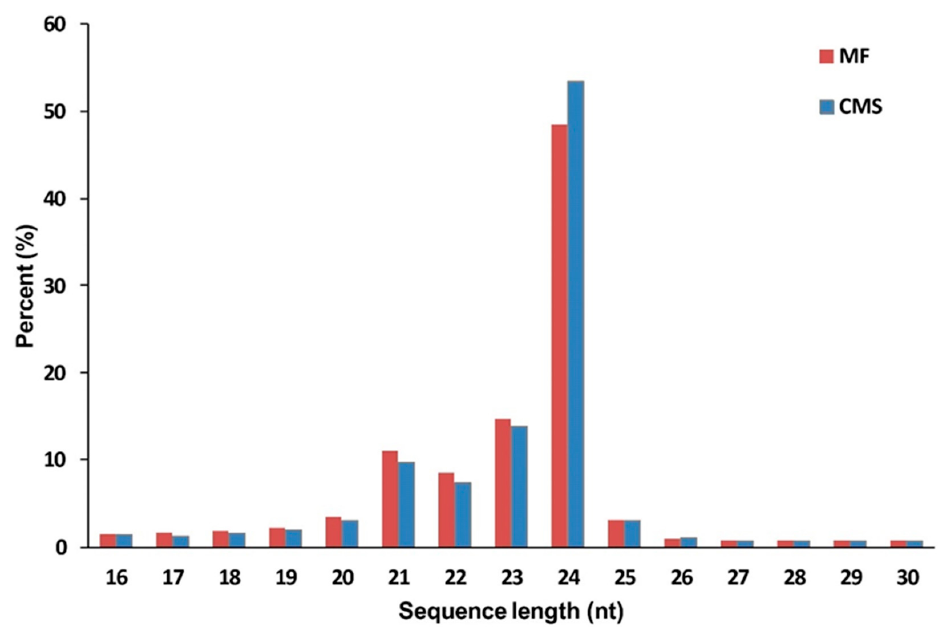
Figure 3. The size distribution of the small RNAs between MF and CMS libraries of